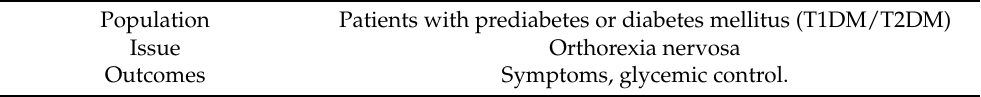
Table 1. The PIO components of the study’s research question. Population Issue Outcomes Symptoms, glycemic control.